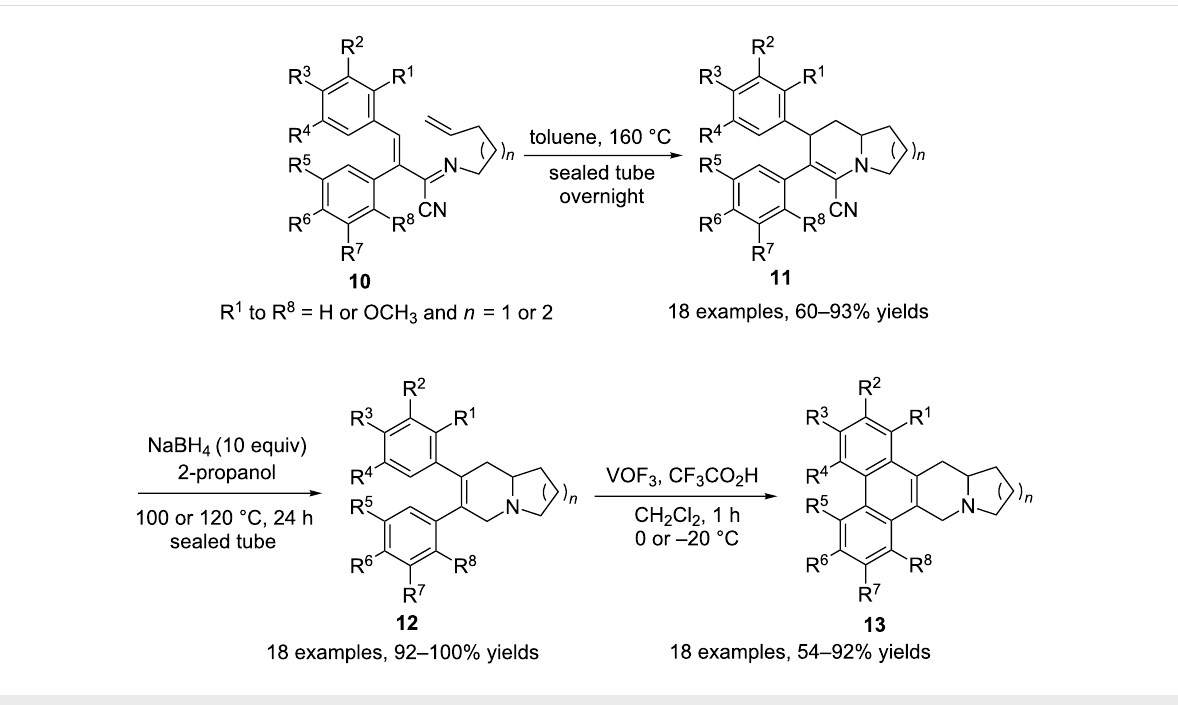
Scheme 7: Synthesis of phenanthroindolizidines and phenanthroquinolizidines